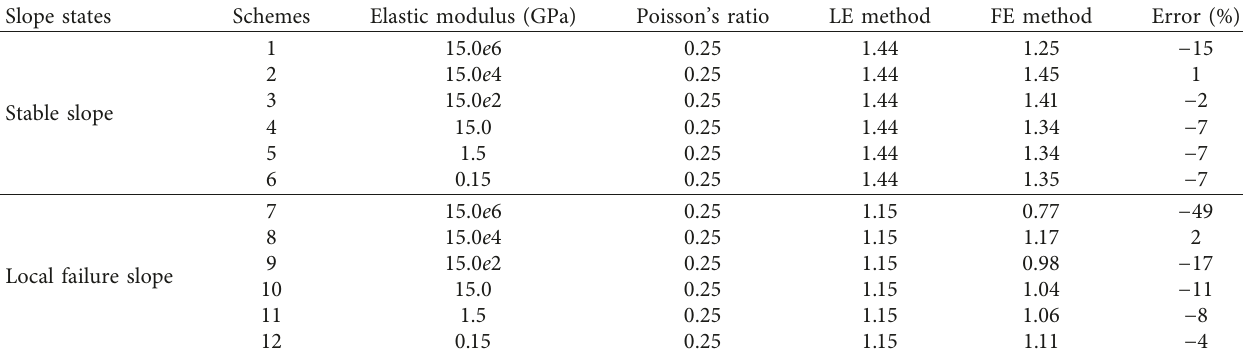
Table 7: Influence of sliding body elastic modulus on safety factors and error range.